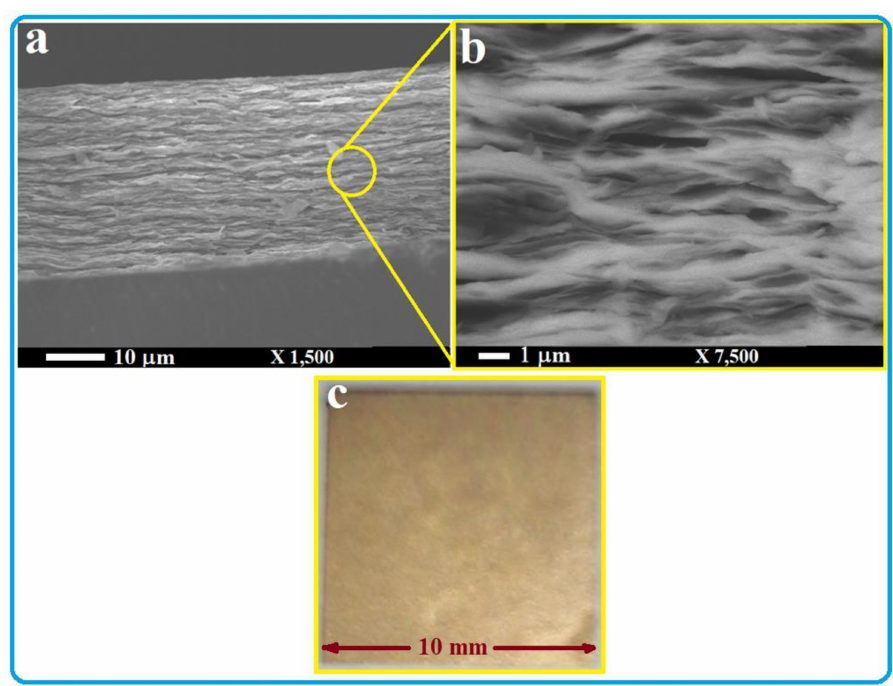
Figure 1. SEM images ( a , b ) of the synthesized film of TiS 2 /organic superlattice. Photograph image of a top view of the film formed on a 10 × 10 mm glass substrate is also shown ( c ).